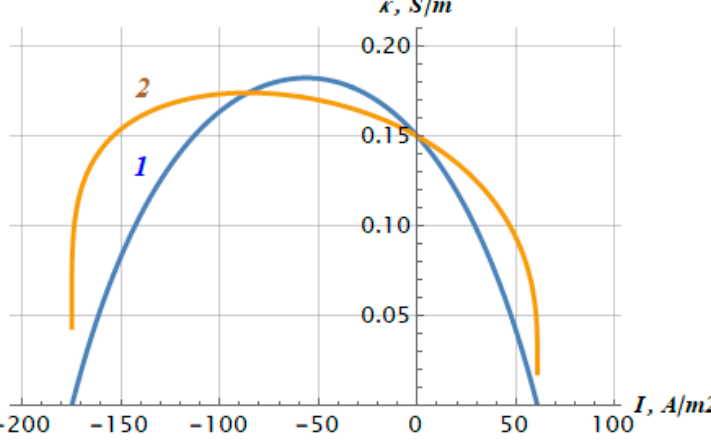
Figure 6. The dependence of the differential conductivity κ (curve 1) and the ratio ( h 1 + h 2 ) I/U (curve 2) of the bilayer membrane MF-4SC/PTMSP in 0.05M HCl solution, on the current density I .